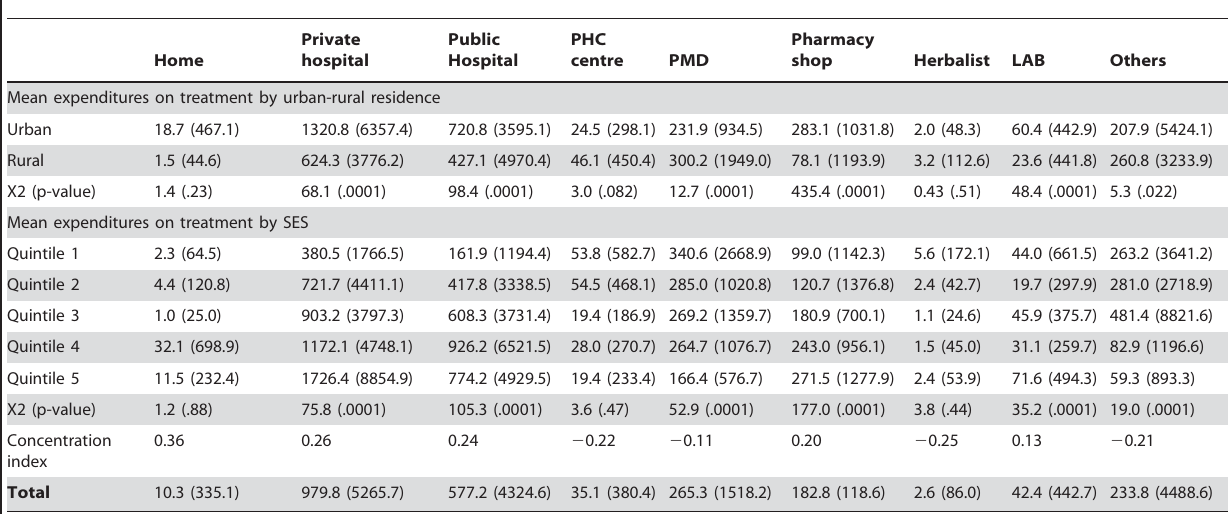
Table 2. Mean monthly household expenditures on treatment paid to different providers (Naira).